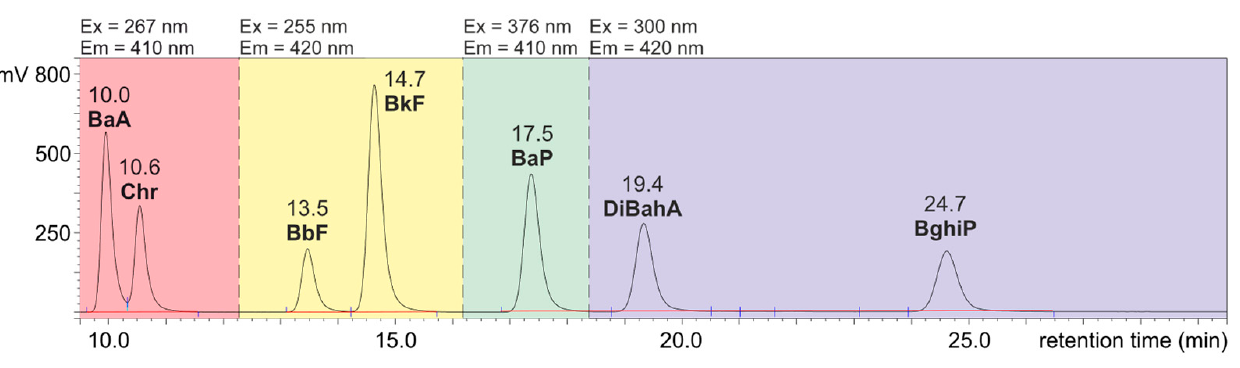
Figure 1. HPLC-FLD chromatogram of PAH standard mixture (injection: 1 ng/10 μ L acetonitrile).